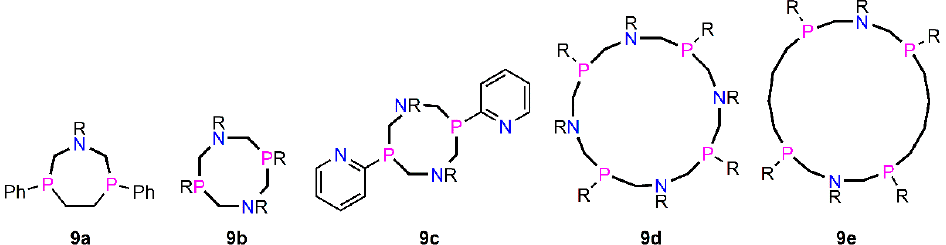
Figure 13. Selected examples of ring structures incorporating P–C–N backbones.